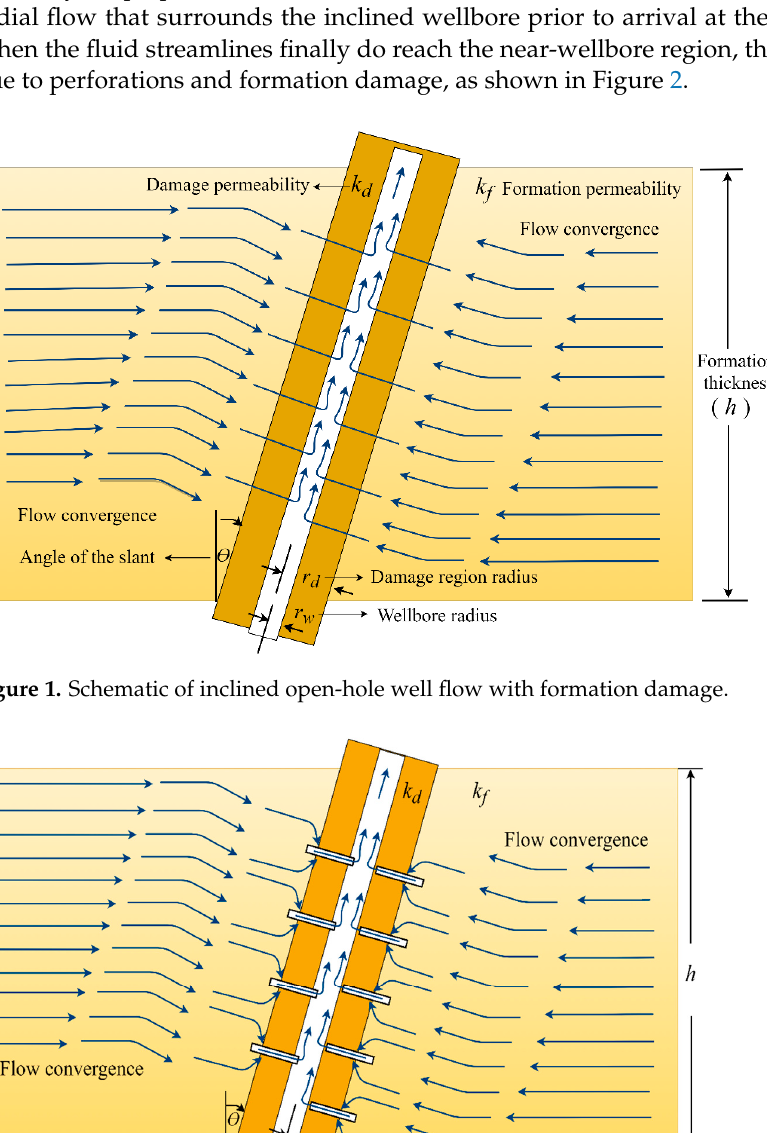
Figure 2. Schematic of inclined and completely perforated well with perforations. Perpendicular to well and formation damage.